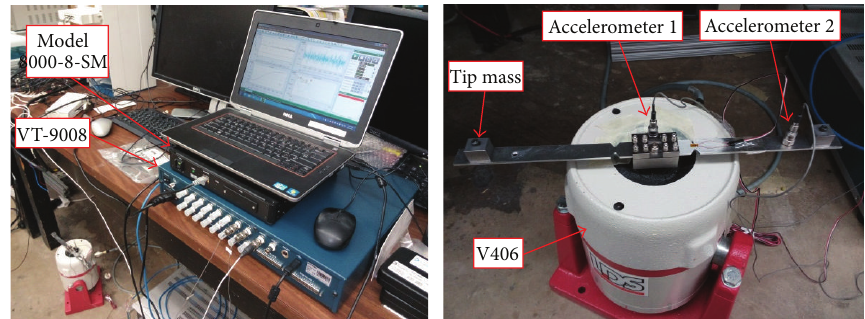
Figure 6: Experimental setup for accelerated random vibration fatigue test.